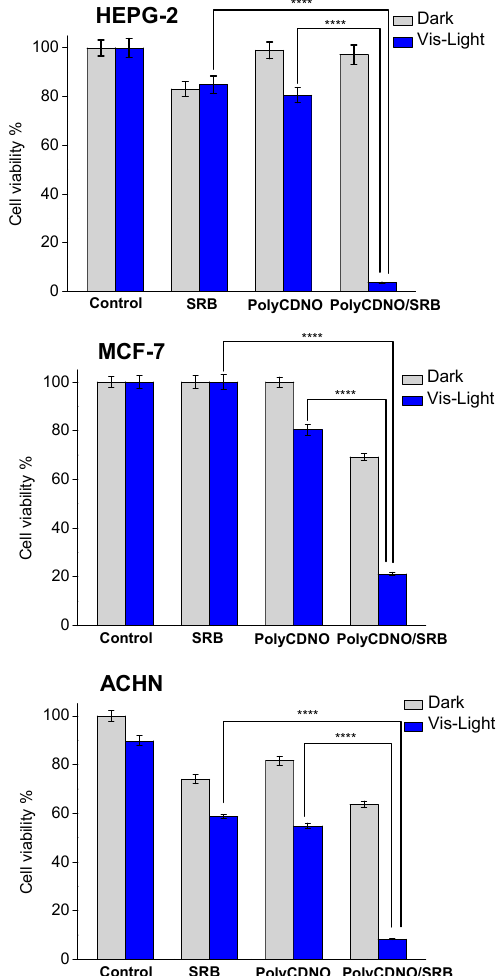
Figure 7. Cell viability observed 24 h after incubating different cancer cells for 4 h with free SRB (1.5 μ g mL − 1 ), PolyCDNO (1 mg mL − 1 ) and the complex PolyCDNO/SRB in the dark and upon 40 min of irradiation at λ exc > 400 nm. (**** p < 0.0001; n = 3) .